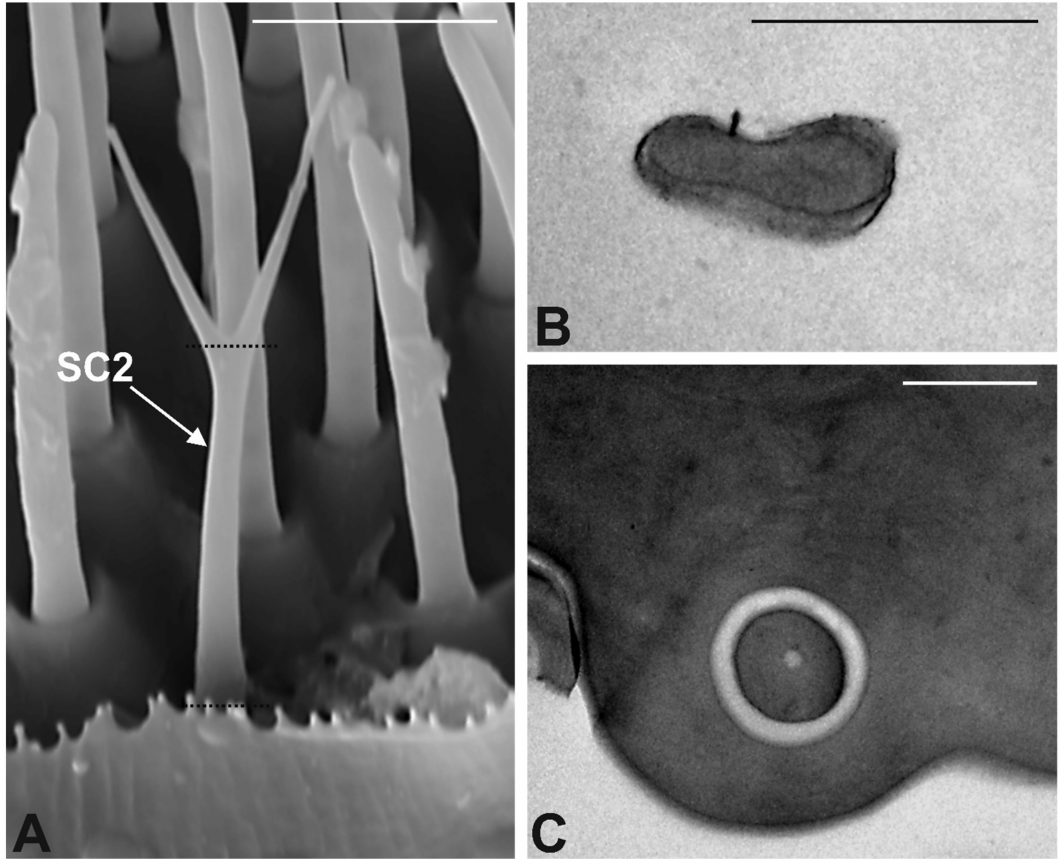
Figure 4. Chaetic Sensilla Type 2 (CS2). ( A ) SEM dorsal view of a CS2 showing the distal part divided into two pointed branches. ( B , C ) TEM micrographs showing cross section of an CS2 taken at the level of the dotted lines reported in A. In both cases the sensillum shows a thick and compact cuticle and the absence of sensory neurons entering the sensillum. Bar scale: ( A ) 5 µ m; ( B , C ) 1 µ m. Basiconic Sensilla Type 1 (BS1). They are typical “peg” sensilla, with an average length of